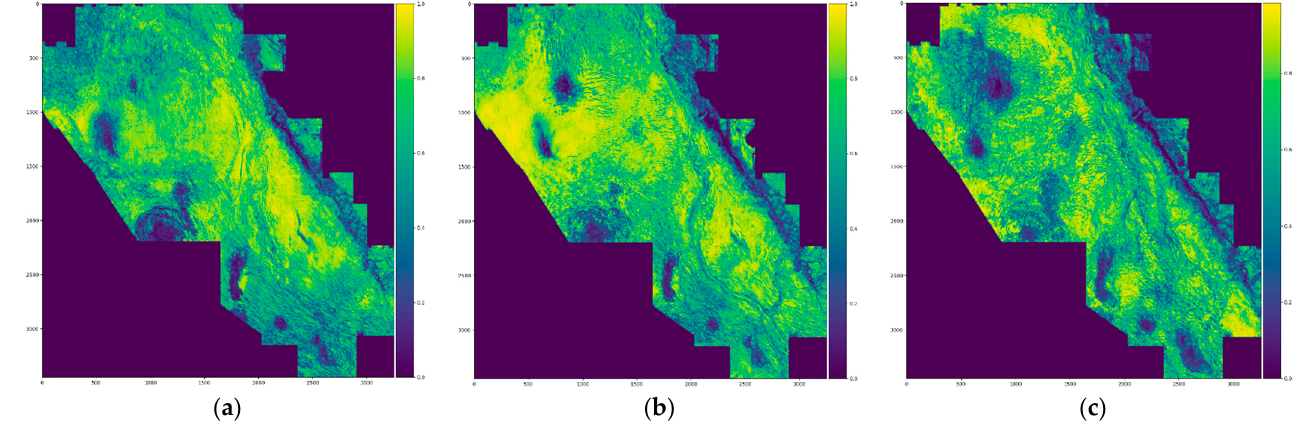
Figure 3. The coherence attribute of the seismic reflection interfaces T30–T50. ( a ) T30, ( b ) T40, ( c ) T50.